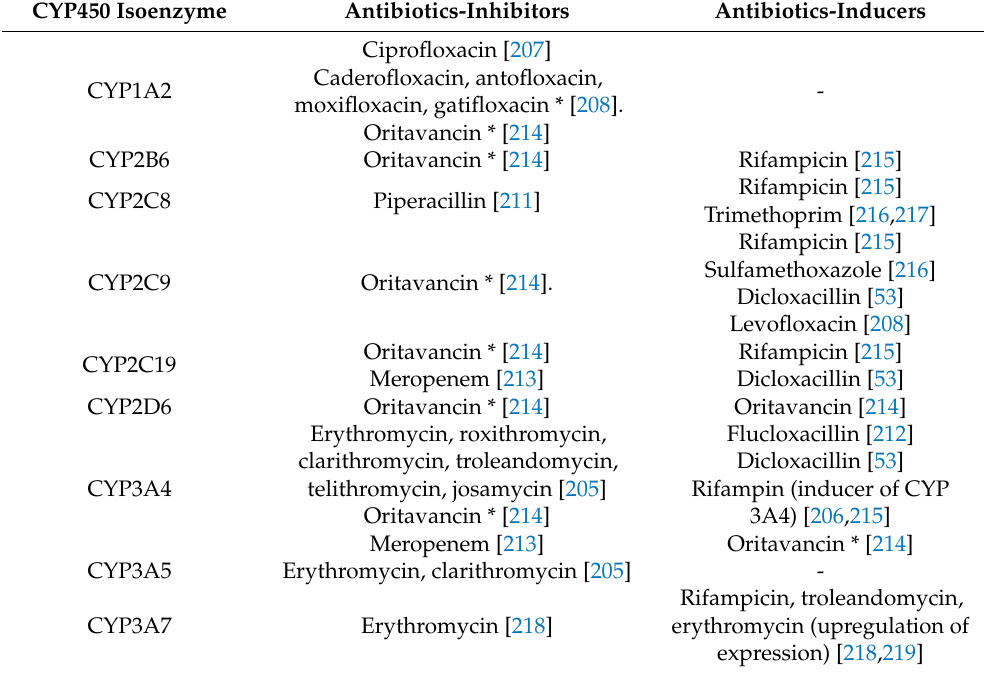
Table 8. Effect of antibiotics on human CYP450 enzymes (direct and indirect). CYP450